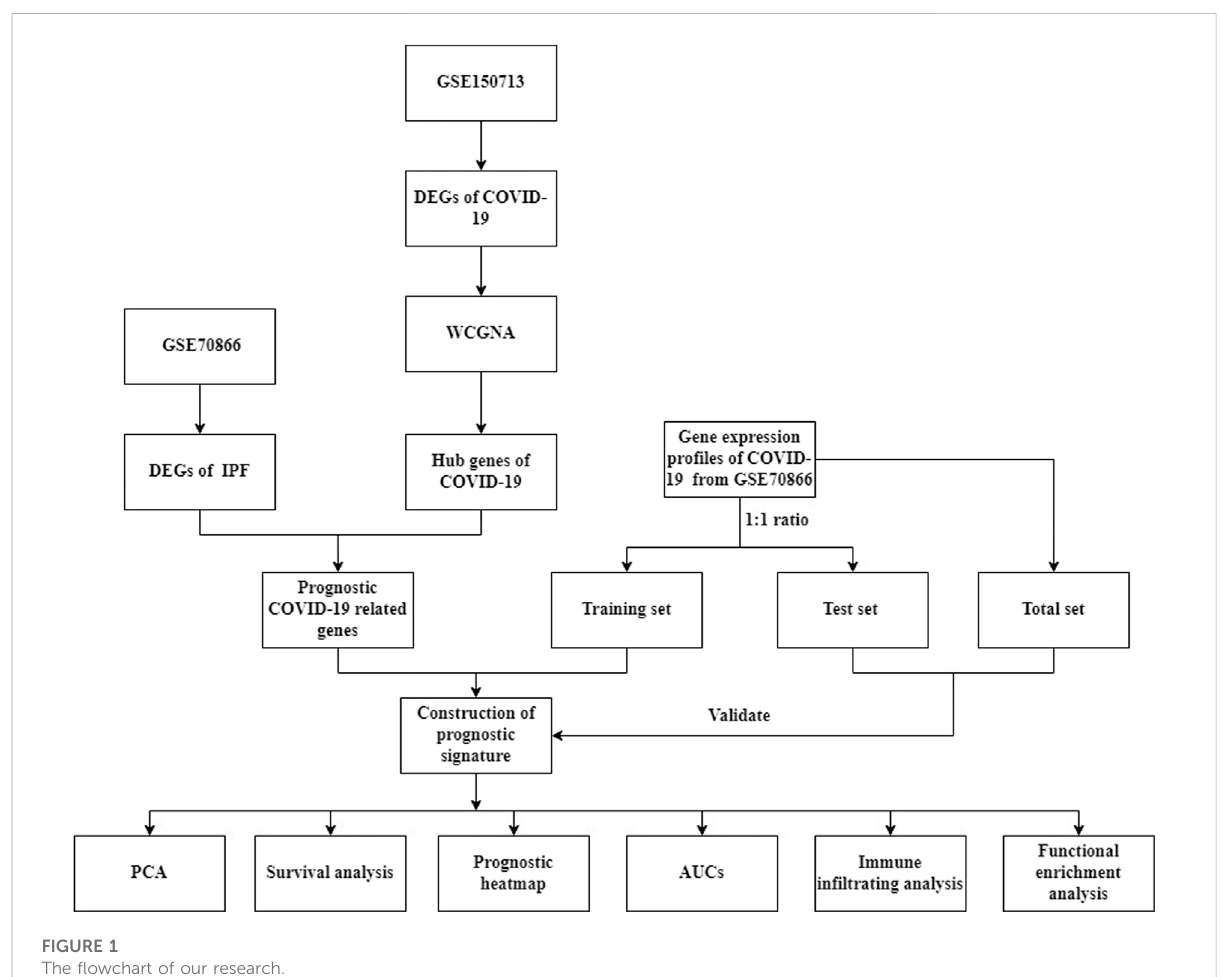
FIGURE 1 The fl owchart of our